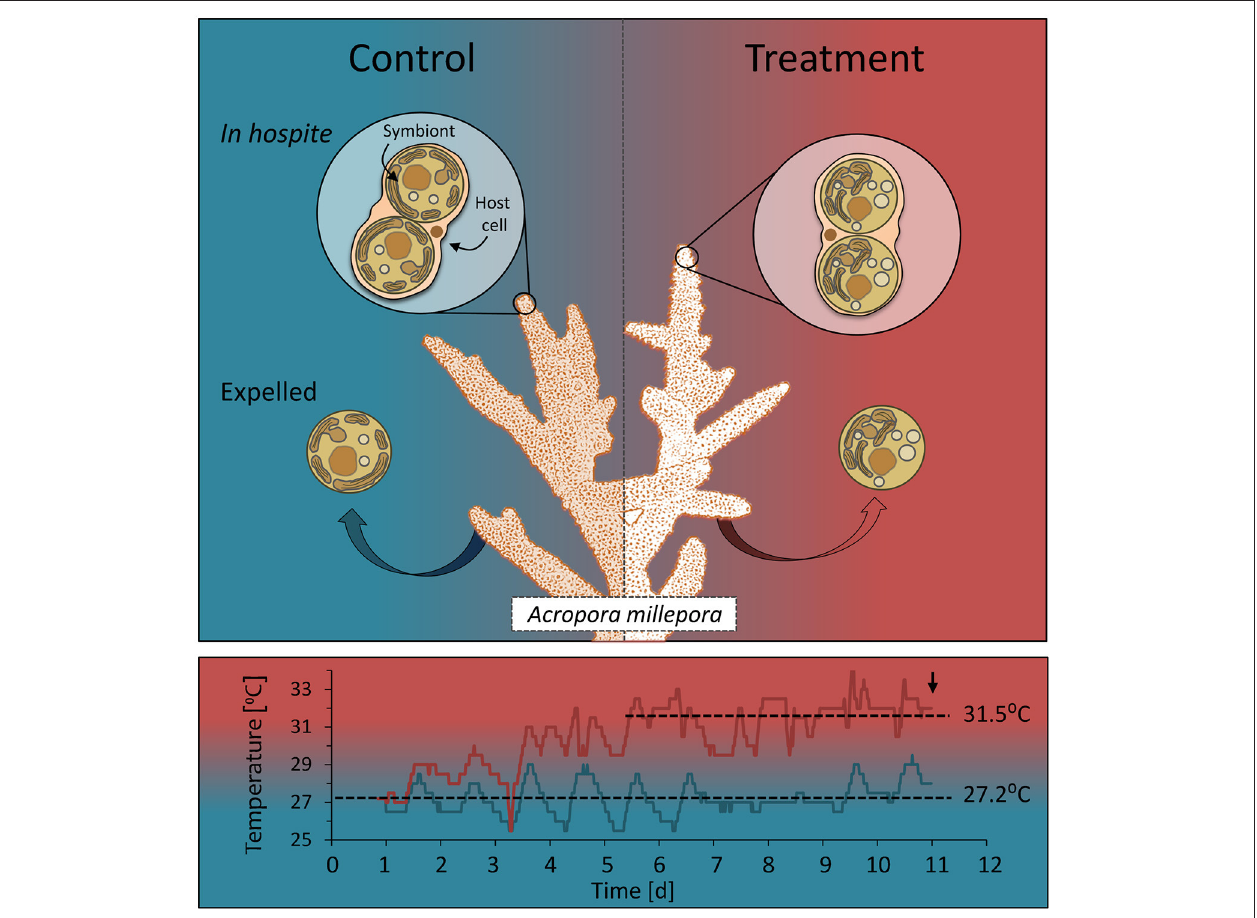
FIGURE 1 | Sampling design showing cell types and temperature treatments. Colonies ( n = 3) of the reef building coral Acropora millepora were divided in two and the two halves subjected to one of two temperature regimes: ambient summer temperatures (average 27.2 ◦ C), and warmer temperatures (average 31.5 ◦ C), following a 1-week, incremental increase. Samples from each colony and treatment of endosymbiotic ( in hospite ) and actively expelled cells were collected over 3 consecutive days (9, 10, 11) to capture the day of maximum bleaching, day 11 (down arrow). These cells (control and heat-treated) were then used for single-celled chl a fluorescence analysis, microscope imaging and biomolecular